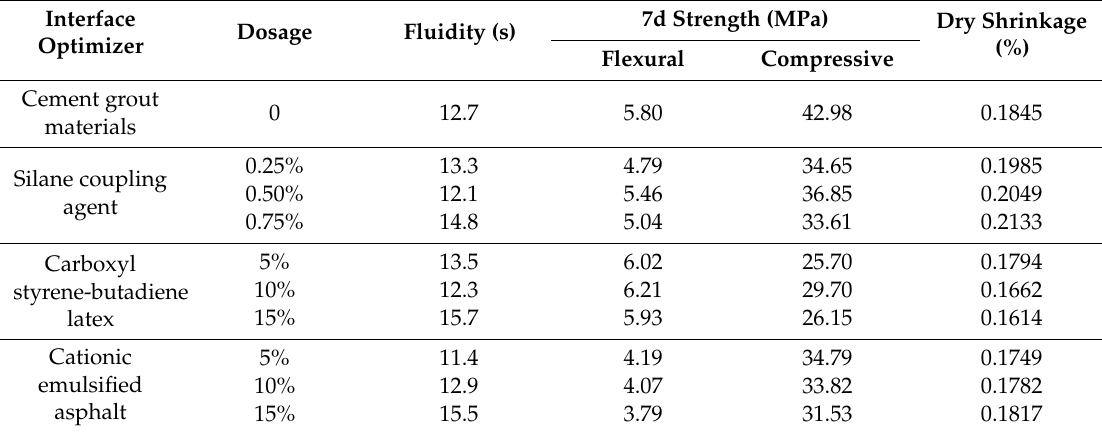
Table 7. Test result of silane coupling